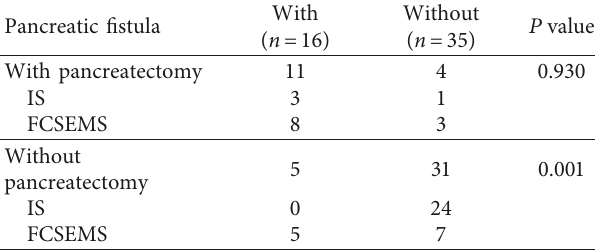
Table 5: Postoperative complications of pancreatic fistula classified with and without hepatectomy and